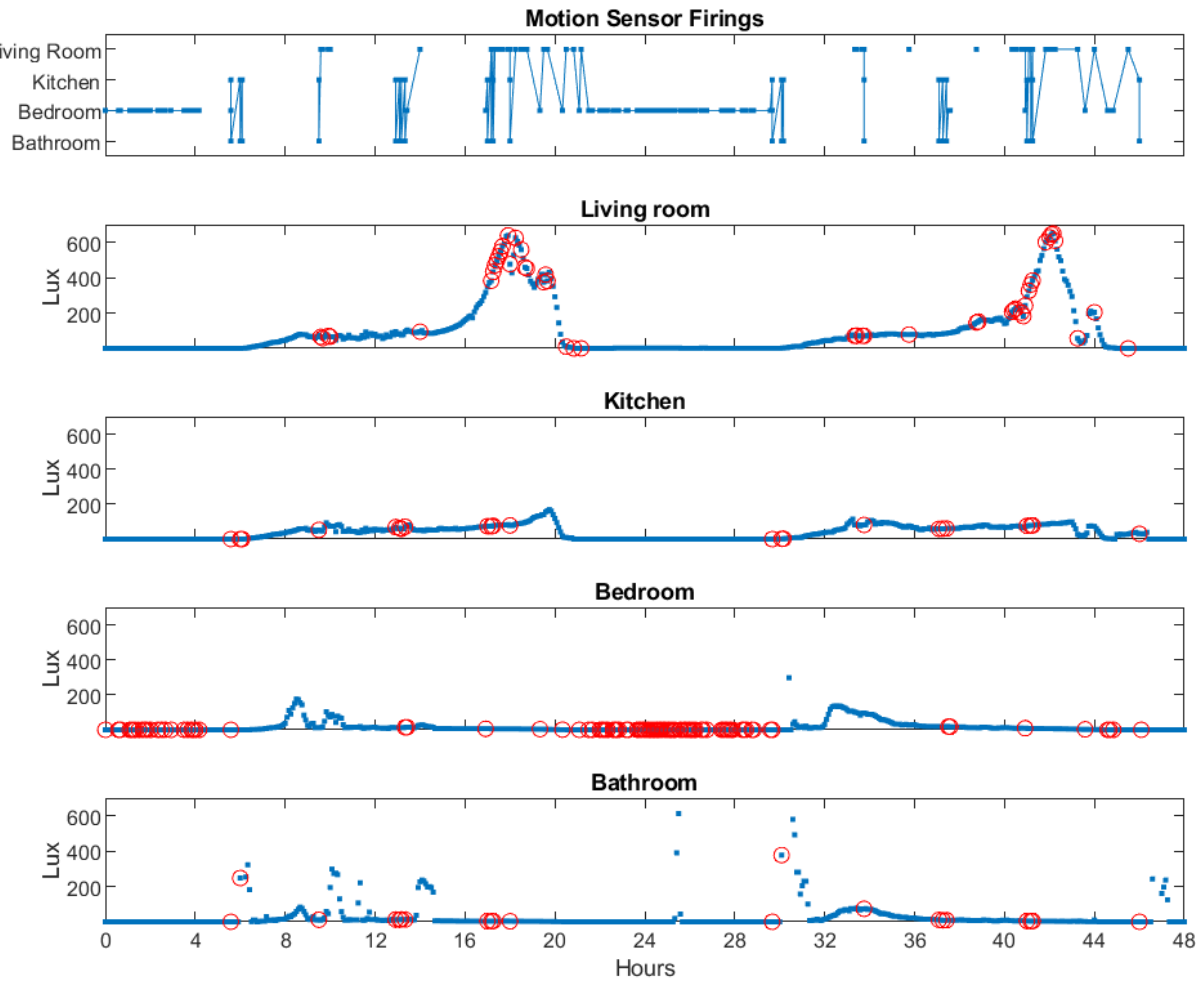
Figure 4. Top panel: motion sensor firings in a single person home over a two-day (48 h) period, showing motion detection events in four rooms of the home. Gaps in data represent sedentary be ‐ havior or the individual not being present in one of these four rooms. The second through fifth panels show the white light measurements taken every five minutes by an Actiwatch Spectrum Pro sensor in each of four rooms, with measurements corresponding to motion sensor firings marked with red circles.